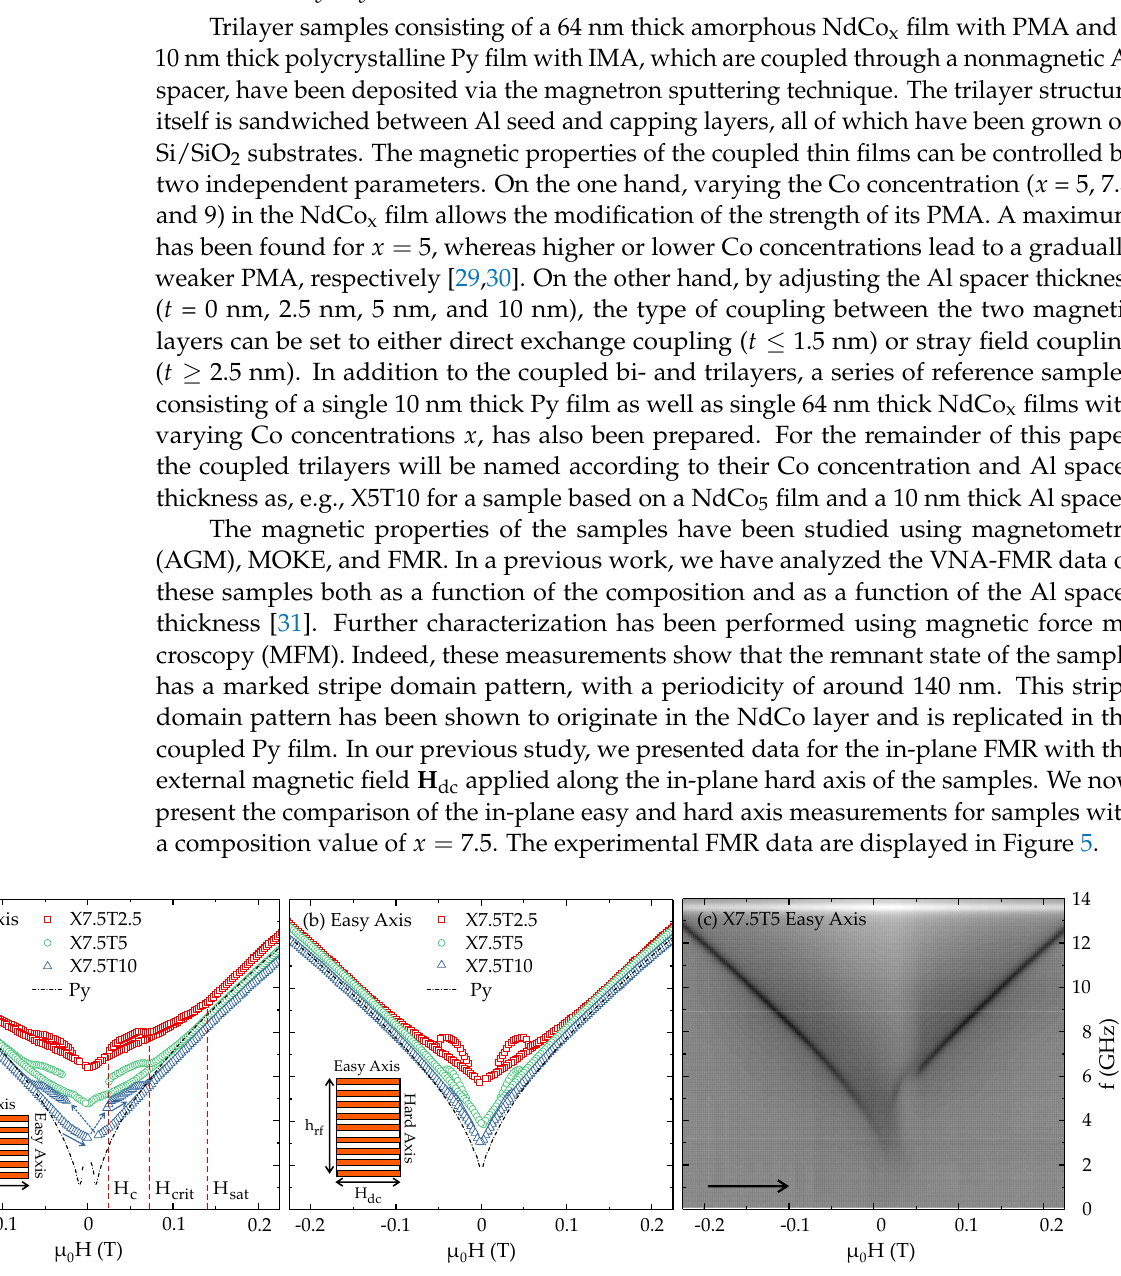
Figure 5. In-plane frequency–field characteristics for VNA-FMR measurements of samples with composition x = 7.5. The f – H characteristics are shown for the hard ( a ) and easy ( b ) axis of the sample. The corresponding insets illustrate the field configurations with respect to the in-plane hard and easy axis along with the virgin-state stripe domain pattern, after initial saturation at H dc = + 0.9 T along the in-plane hard or easy axis. ( c ) Raw VNA-FMR data for the easy axis of sample X7.5T5 for the up-swept field, showing the absorption line discontinuity passing through